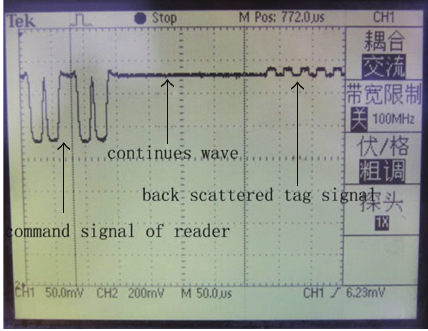
Figure 8: output port of the detector which contains the command signal, continuous wave of reader, and back scattered tag